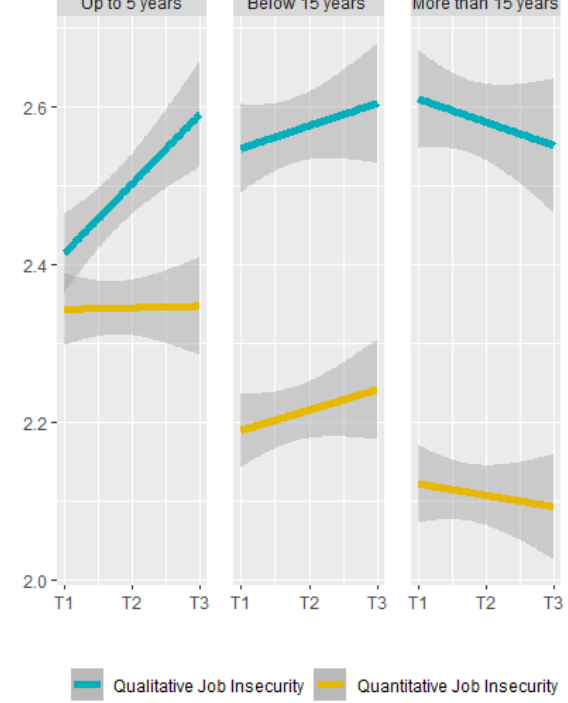
Figure A4. Organizational tenure.